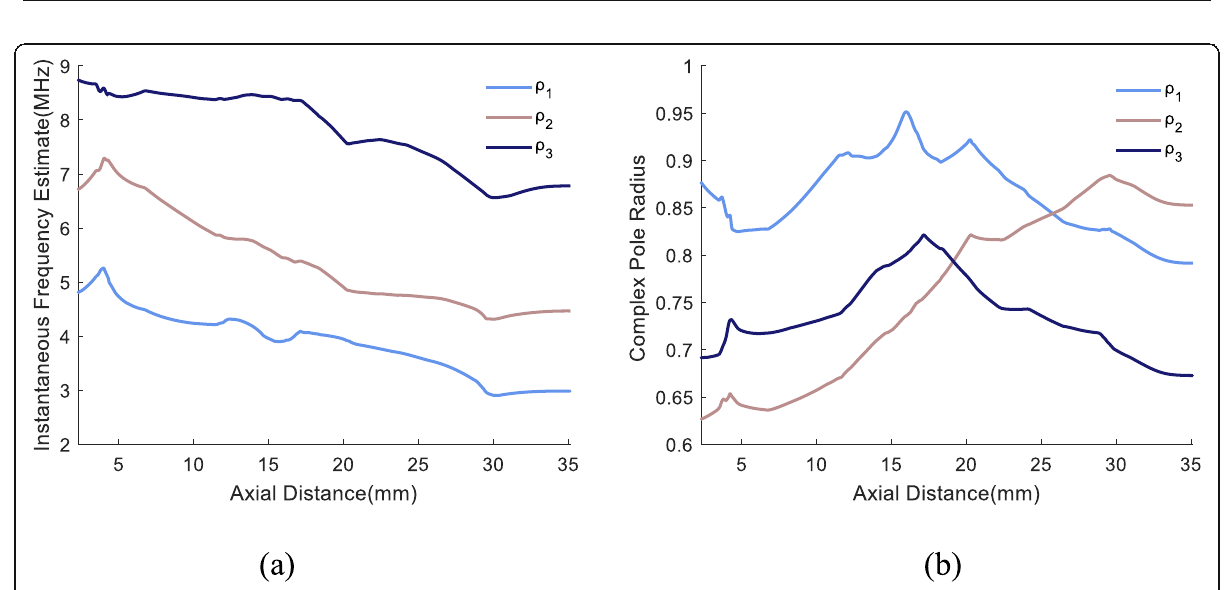
Fig. 9 a Estimated TV-ARMA PSD. b STFT spectrogram using a window of 150 samples and an overlap of 149 samples. c CWT using the Bump wavelet. d Smoothed pseudo-WVD